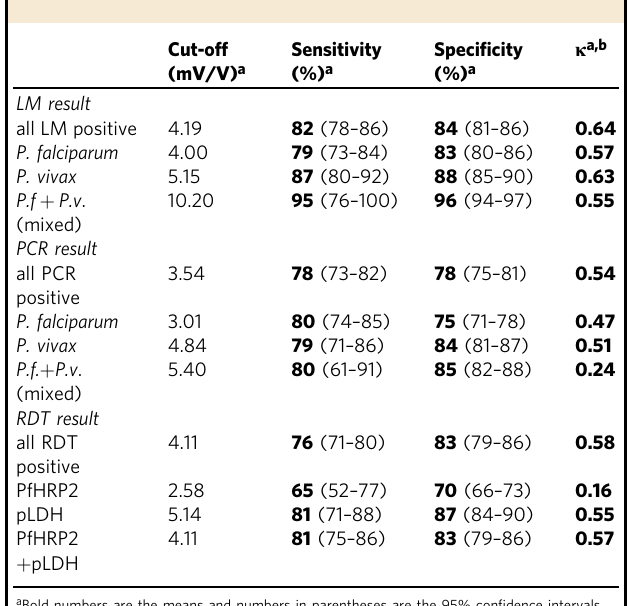
Table 2 Cut-off values, and estimated sensitivity and speci fi city of RMOD resulting from ROC analysis performed using different reference methods (LM, PCR, RDT) and different infection characteristics.